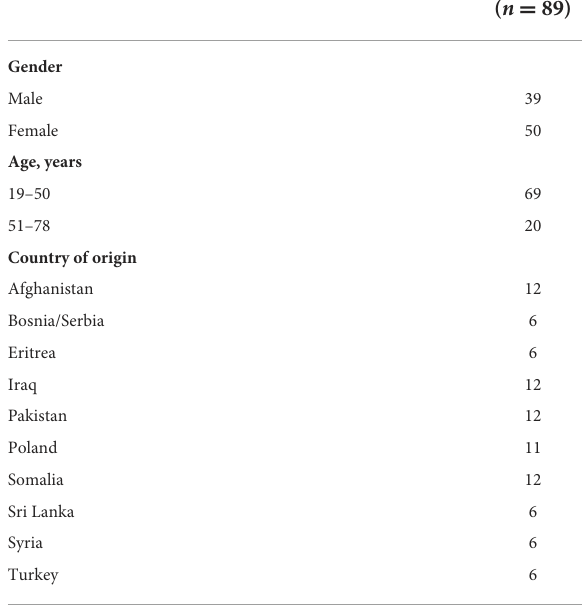
TABLE 1 Characteristics of study